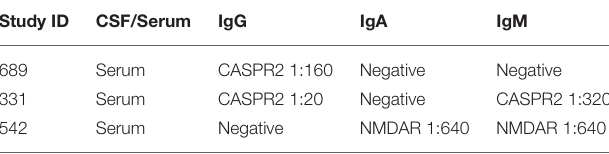
TABLE 2 | List of neural autoantibody-positive samples.